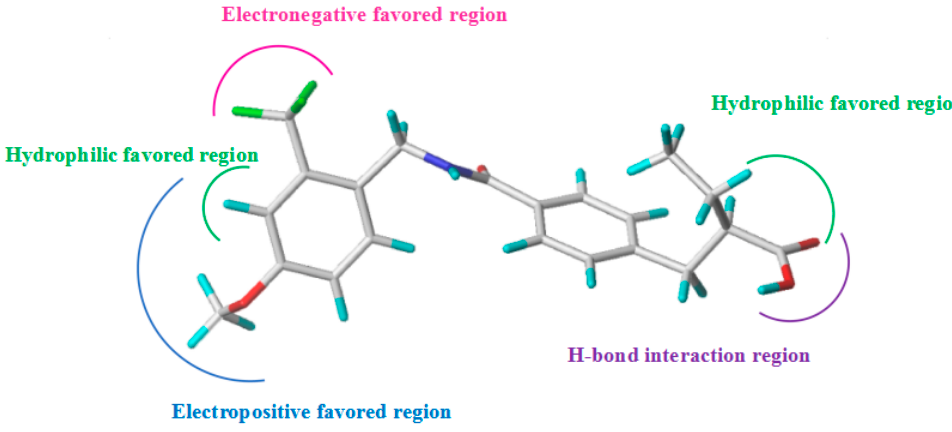
Figure 6. Diagram of structure-activity relationship based on core structure of template compound 24c .